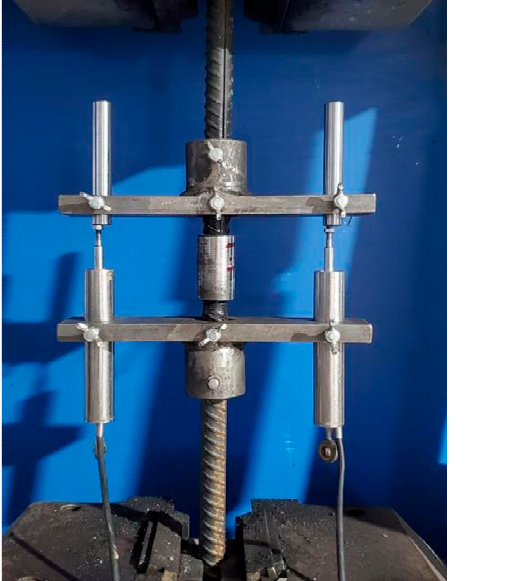
Figure 14. Tensile test setup for different bar connectors.